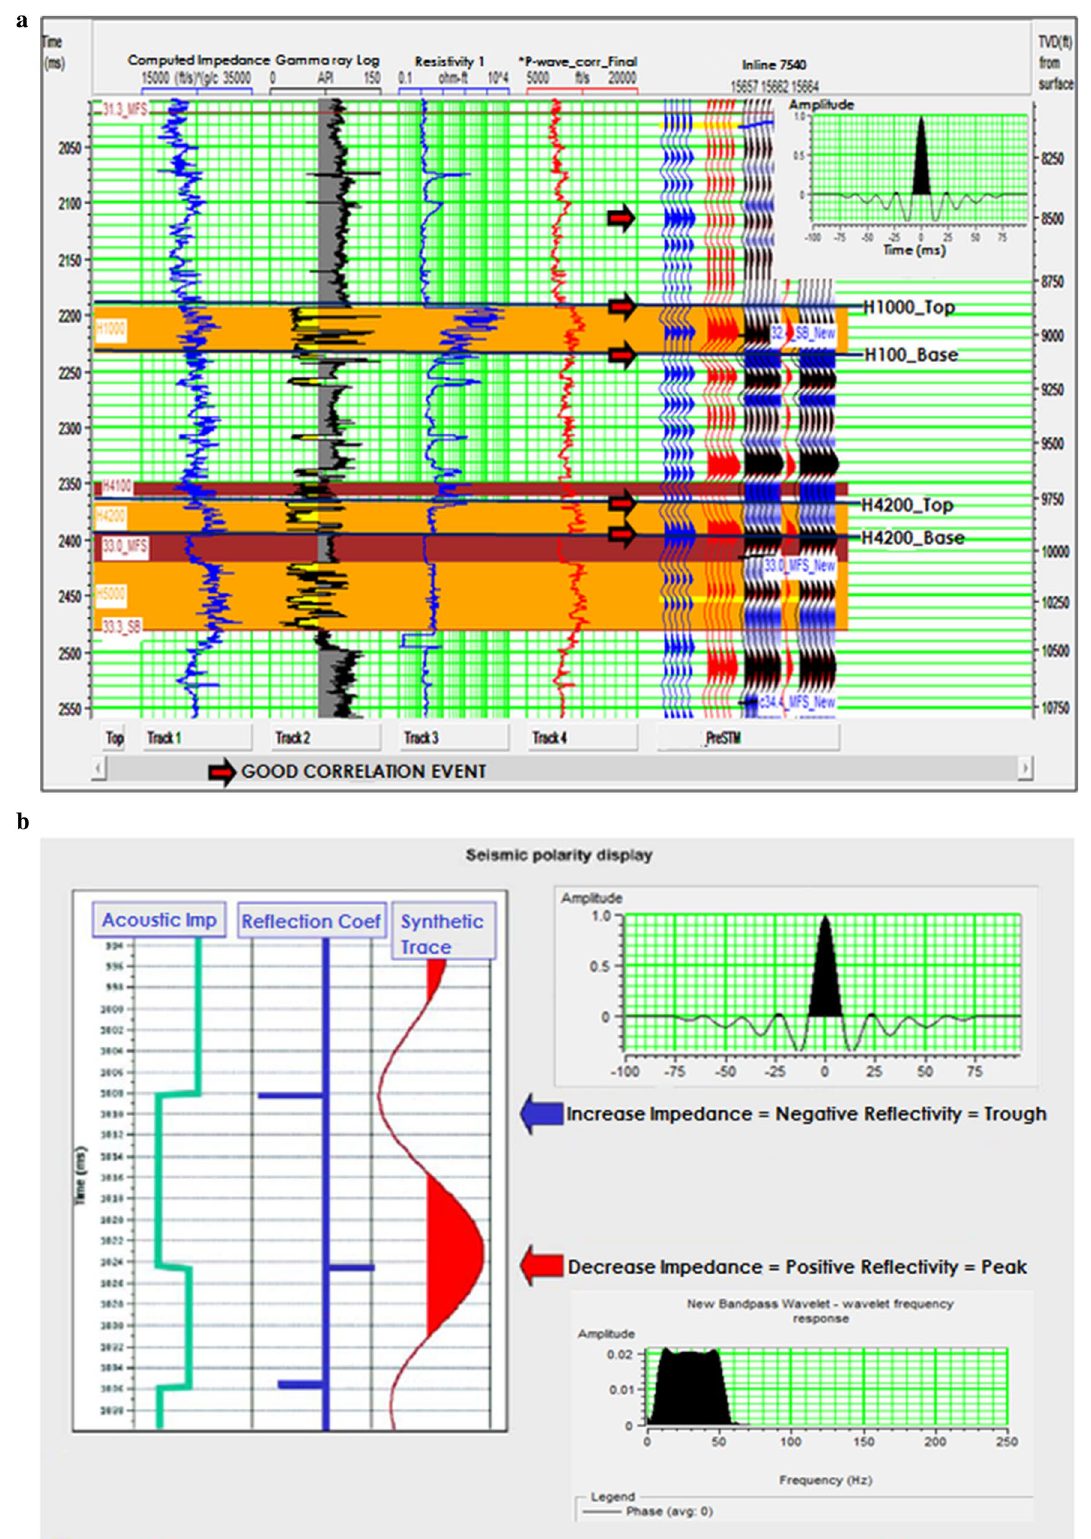
Fig. 7 a Well to seismic section showing synthetic matching with H1 res- ervoir TOP (as H1000_Top) and BASE (as H1000_Base) as trough event. Insert: extracted zero phased wavelet. b European polarity display, whereby